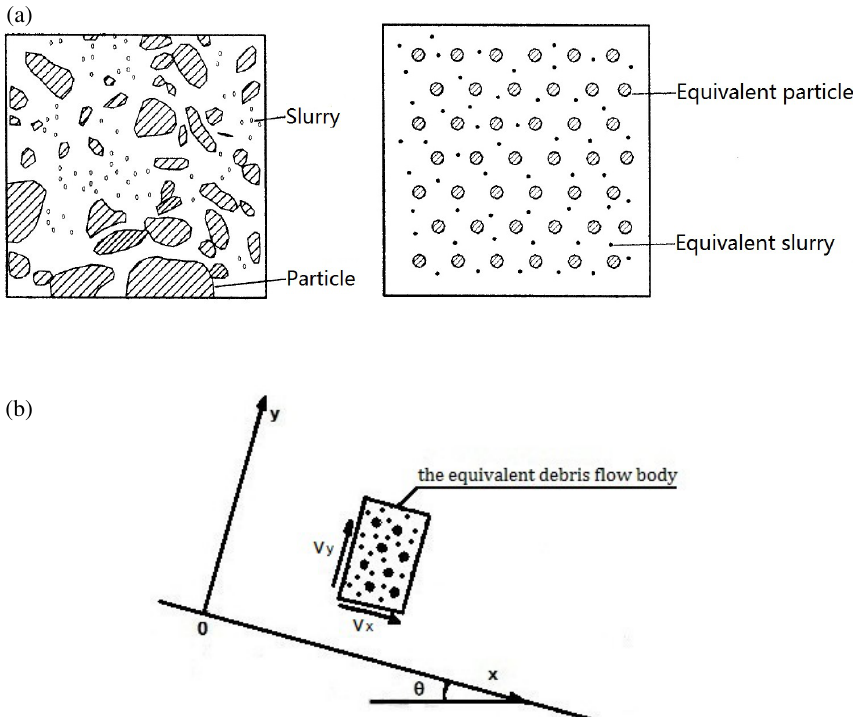
Figure 1. Configuration of the equivalent two-phase debris flow: x indicates downstream direction, y indicates normal to the slope, θ indicates slope angle, v x and v y indicate the velocity components along the coordinate axes x and y ,